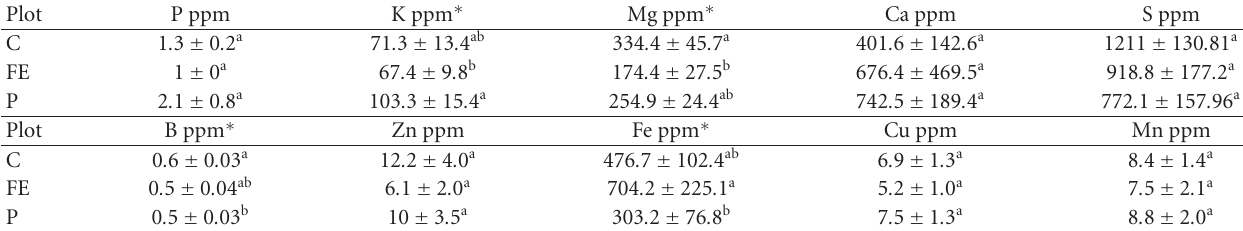
Table 2: Comparison among habitat types (C = center, FE = forest edge, P = pine plots) with regard to soil concentrations of macro- and micronutrients obtained from soil samples from plots. Values are expressed as ± 1 SE. Means sharing the same letter do not di ff er significantly according to α = 0 . 05 to Tukey’s